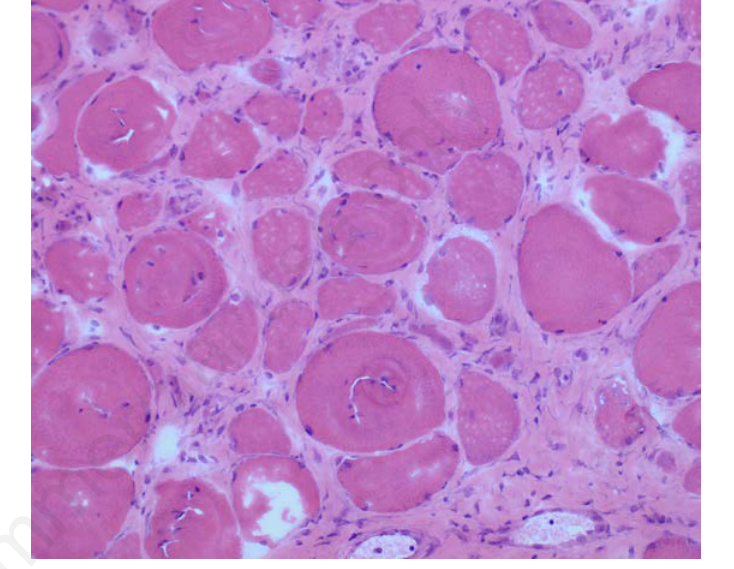
Figure 1. The picture demonstrates size variability with fibrosis.